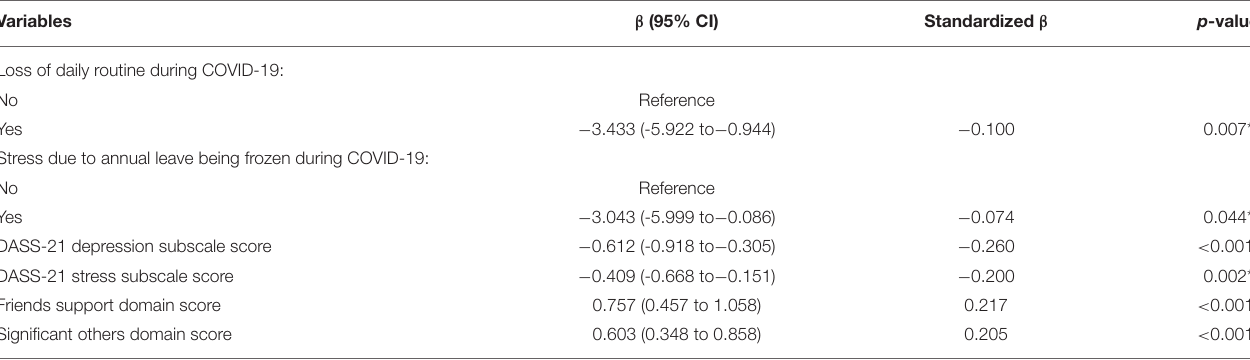
TABLE 4 | Multiple linear regression analysis with backward selection method between demographic and personal characteristics, COVID-19 related factors, psychological characteristics, perceived social support, and psychological QoL among the respondents. Variables β (95% CI) Standardized β p -value